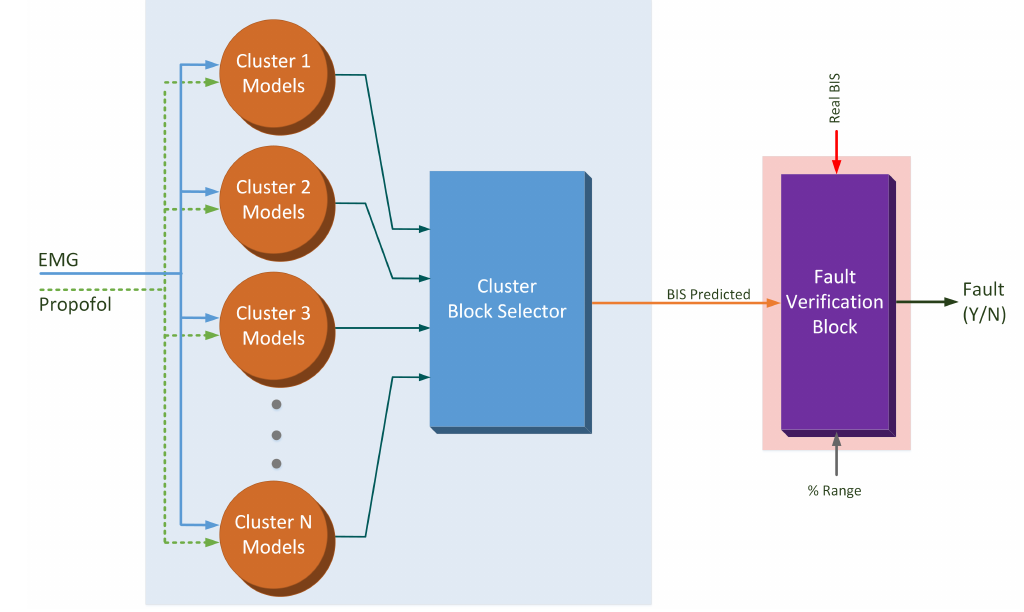
Figure 4. BIS case. EMG: